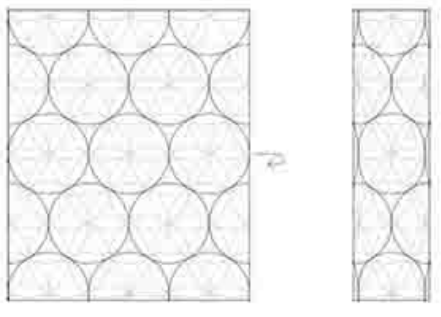
Figure 6: Projecting patterns on an unrolled cylindrical surface